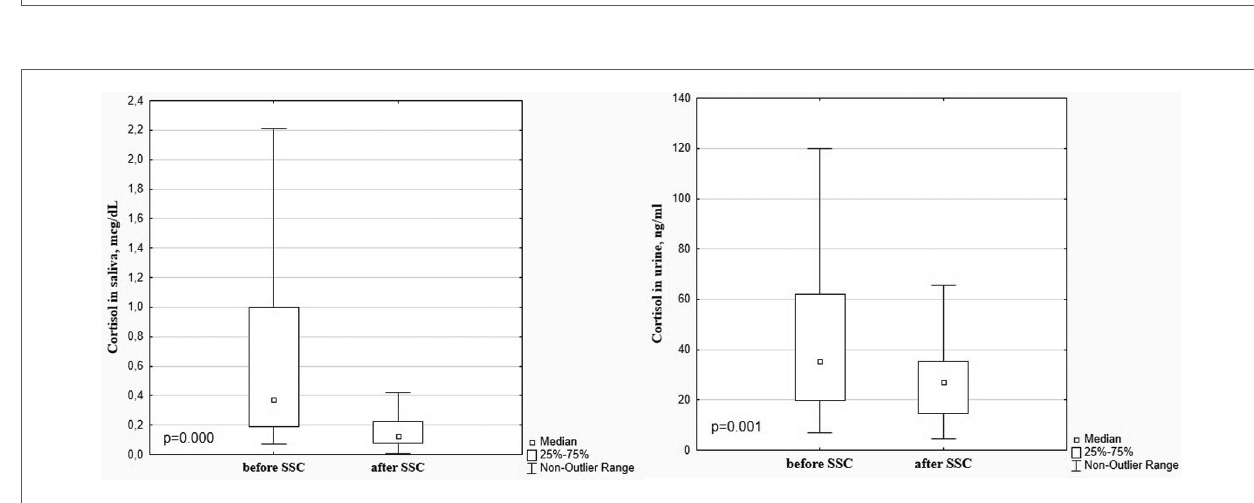
FIGURE 3 Cortisol in saliva and urine in preterm infants before and after SSC.